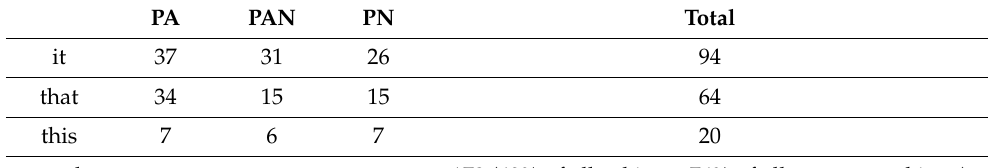
Table 2. Inanimate pronoun subjects found in PA, PAN and PN constructions. PA PAN PN Total that this total 178 (60% of all subjects, 76% of all pronoun